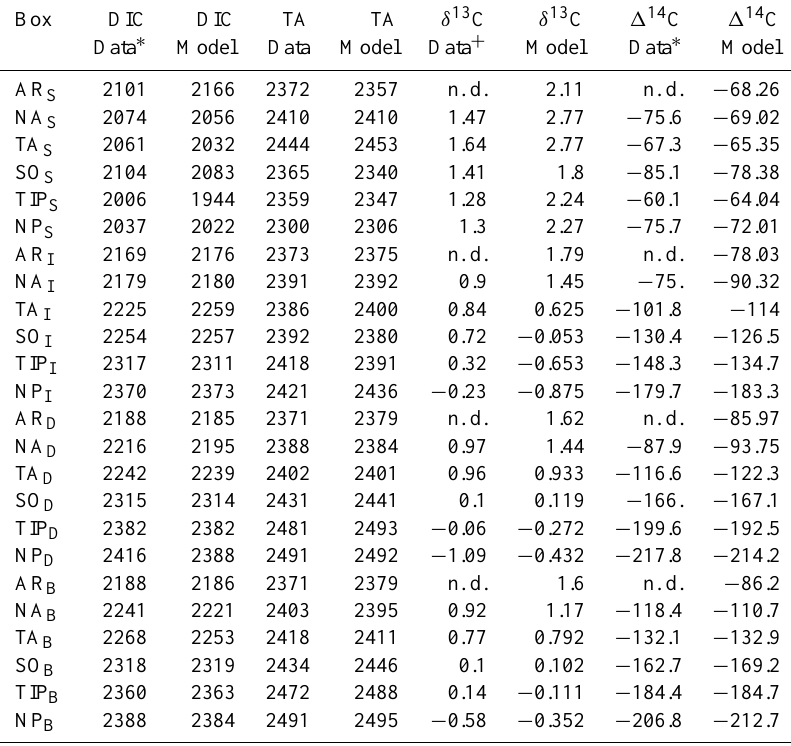
Table A2. Dissolved inorganic carbon (DIC), total alkalinity (TA), δ 13 C-DIC, and (cid:49) 14 C-DIC in model boxes (concentrations in µM, isotope data in ‰): model vs.